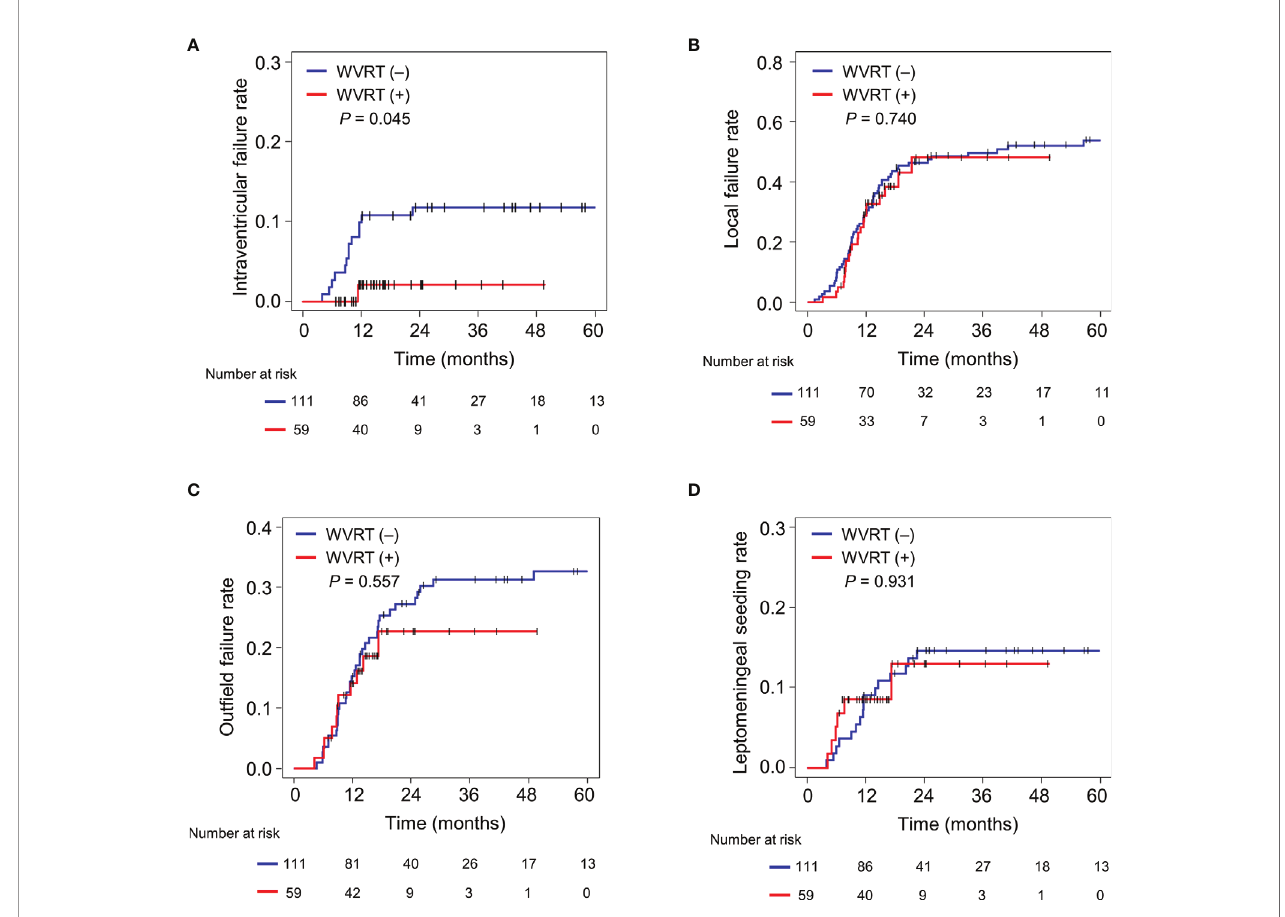
FIGURE 1 | Cumulative incidence rates of intraventricular failure (A) , local failure (B) , out fi eld failure (C) , and leptomeningeal seeding (D) in the propensity score-matched cohort. The cumulative incidence rates were compared between the WVRT ( – ) group (n=111) and WVRT (+) group (n=59). WVRT, whole-ventricular